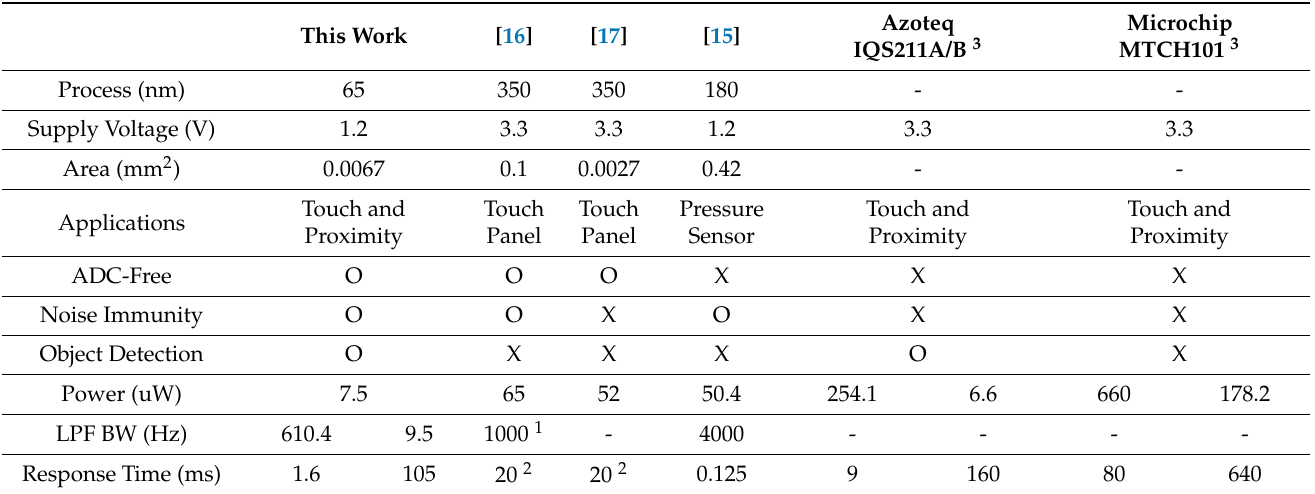
Table 1. Performance comparison